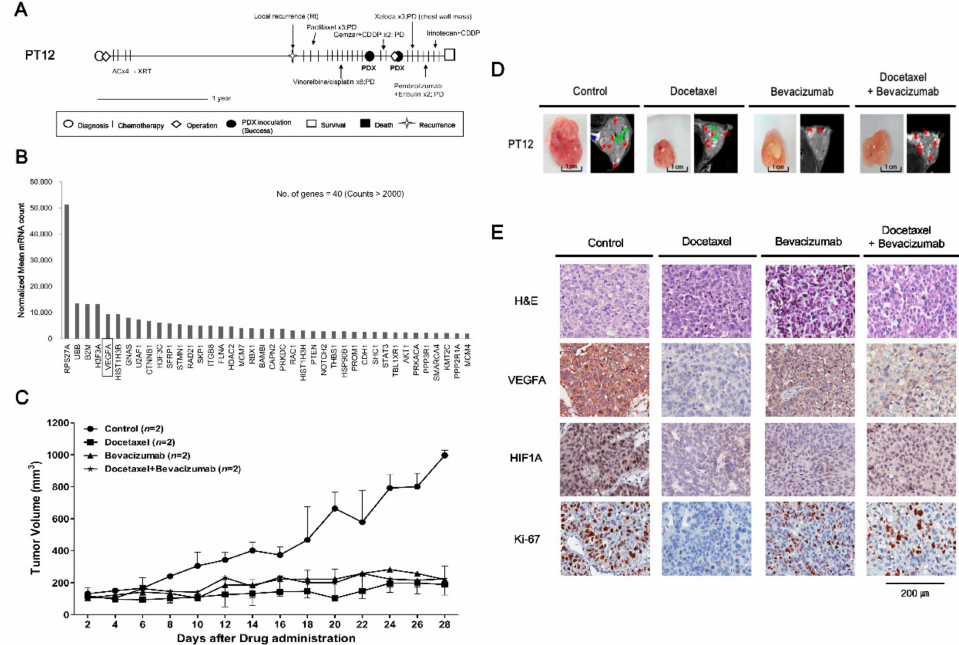
Figure 3. In vivo e ffi cacy of docetaxel and bevacizumab against PDX models from PT12 (TNBC subtype). ( A ) PT12 treatment history. See text for details. Scale bar, one year. ( B ) Gene expression analysis (F3) using a NanoString PanCancer Pathway panel. The top upregulated 40 genes with counts >